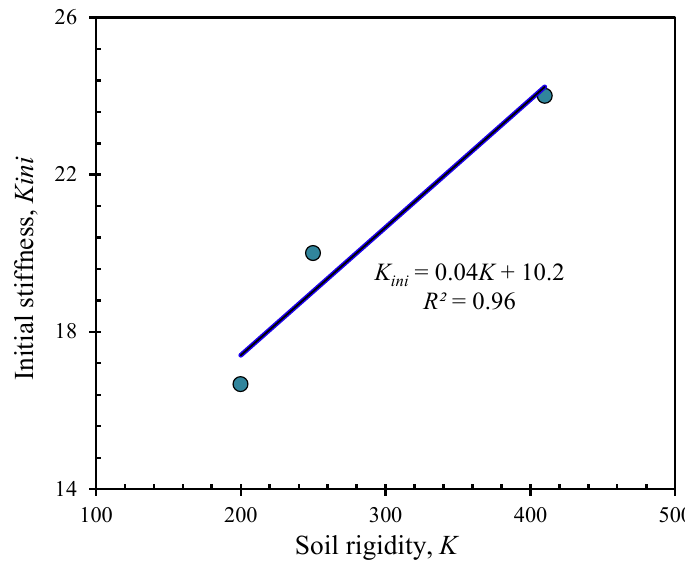
Figure 9. Variation of initial stiffness Kini with soil rigidity K